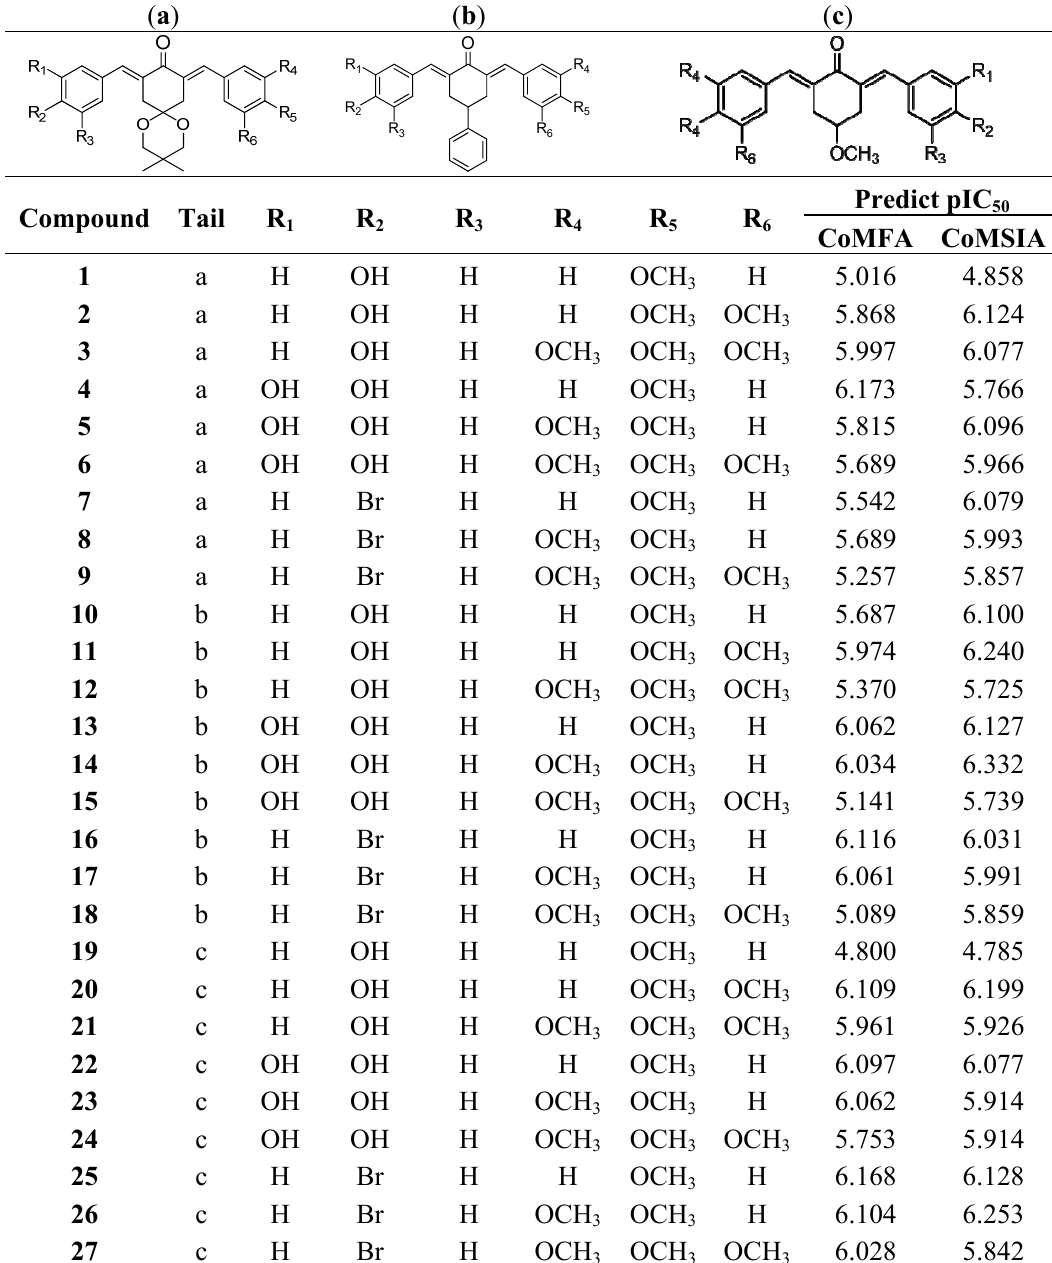
values of ALDH1 inhibitors. 50